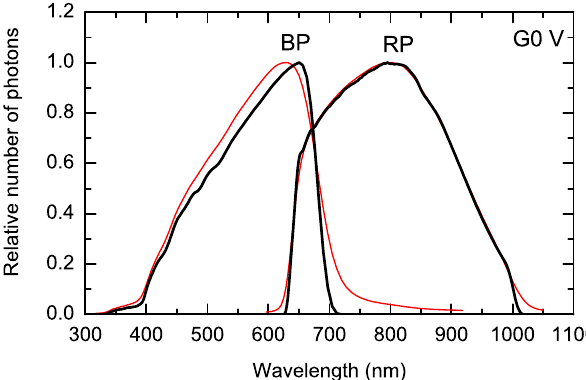
Fig. 4. The same as in Figure 1 but for G0 V type star.